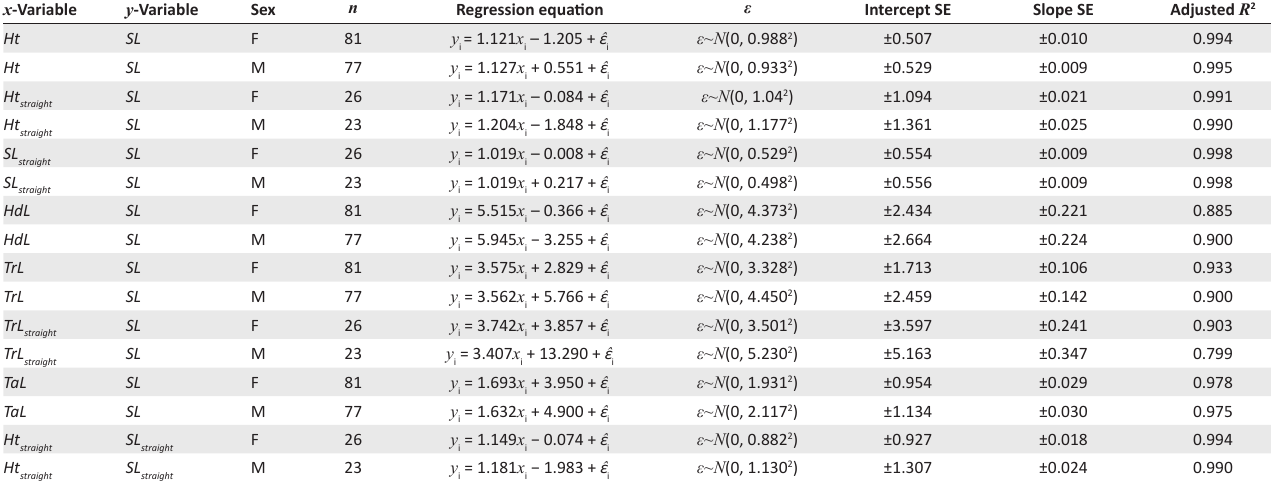
TABLE 1: Correlation between selected morphometric characteristics of Hippocampus capensis collected in 1991. x -Variable